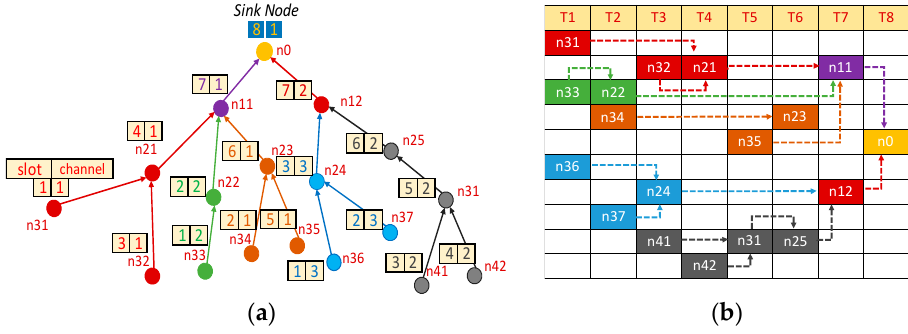
Figure 2. Example, TDMA based data forwarding in WSN: ( a ) presents the data flow in the network; ( b ) illustrates the TDMA scheduling table.